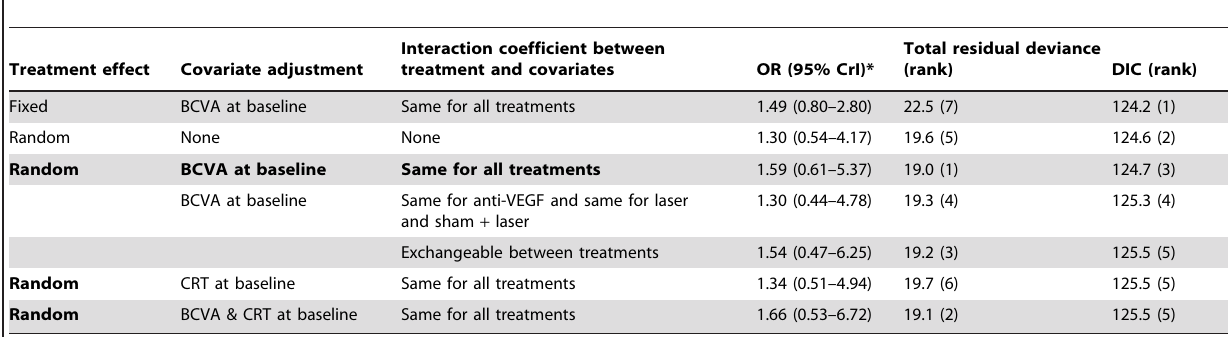
Table 4. Model selection: comparison of the total residual deviance and DIC for Bayesian network meta-analyses with fixed or random treatment effects and baseline BCVA and/or CRT as